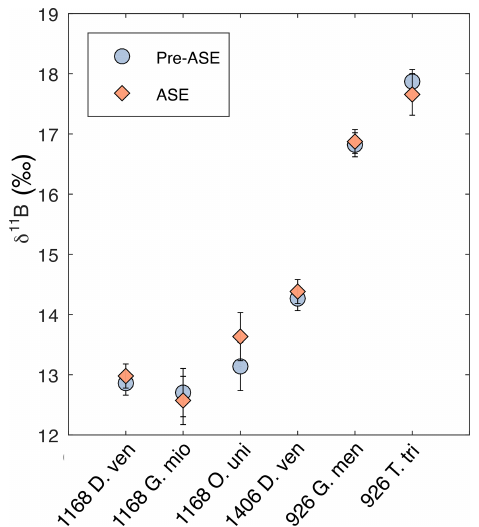
Figure 6. Boron isotopes results for comparison of pre-ASE (blue circles) and ASE-treated (pink diamonds) foraminifera. No off- set between the two treatments is identified, supporting the use of foraminifera from ASE-treated sediments for boron isotope recon- structions of